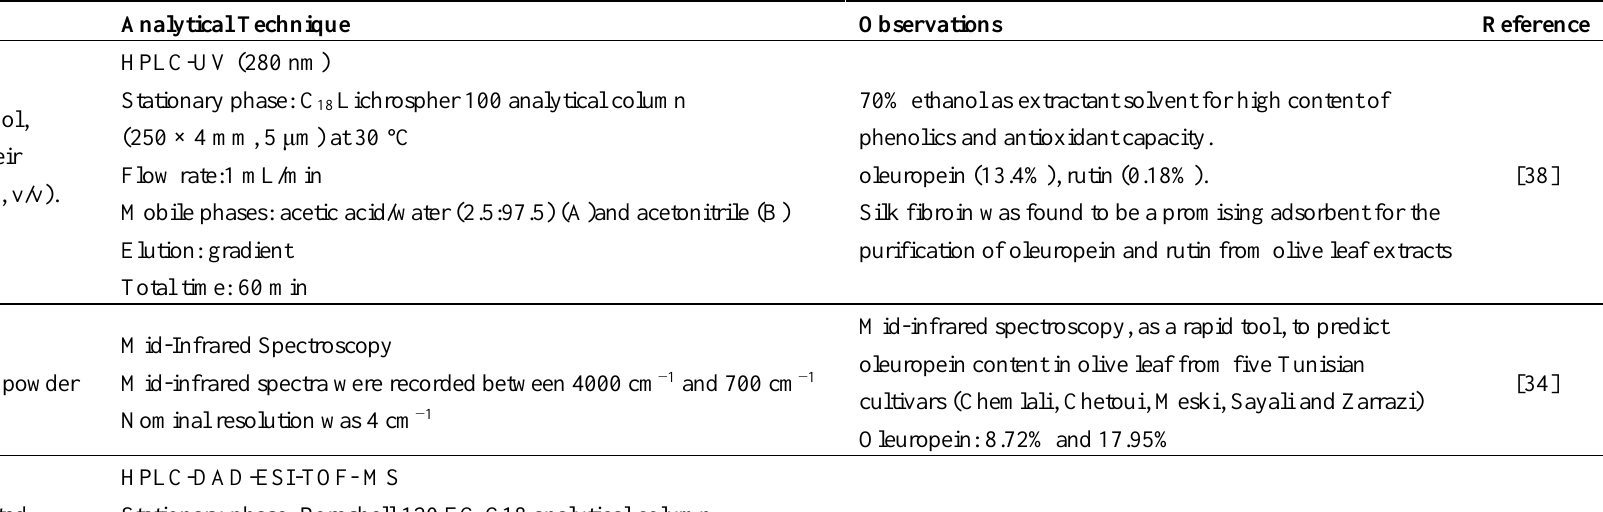
Table 2. Extraction and analysis of phenolic compounds in olive